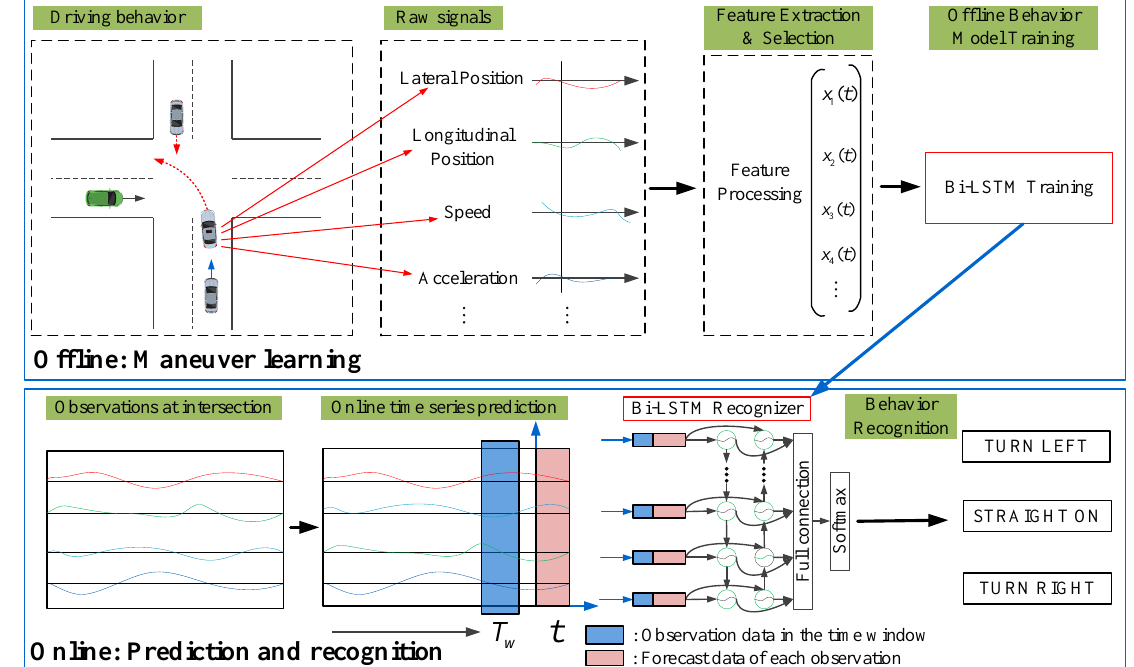
Figure 2. Schematic of intersection behavior prediction and recognition.